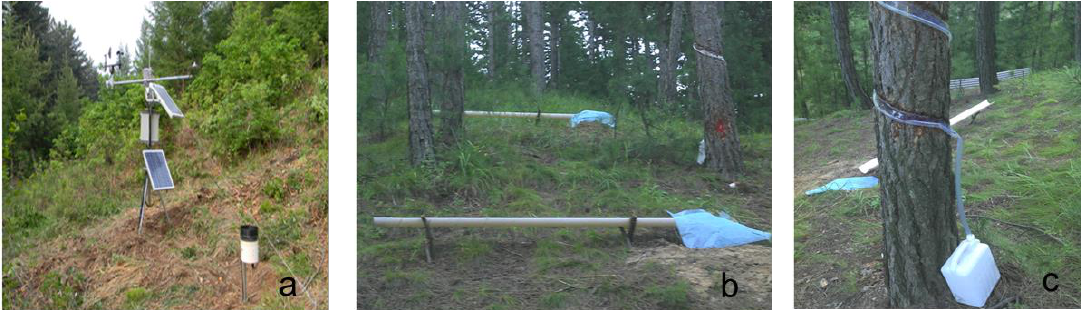
Figure 2. The photos for the experiment plot, ( a ): the auto precipitation gauge in the study, ( b ): throughfall gauge used in this study, ( c ): stemflow gauge in this study.